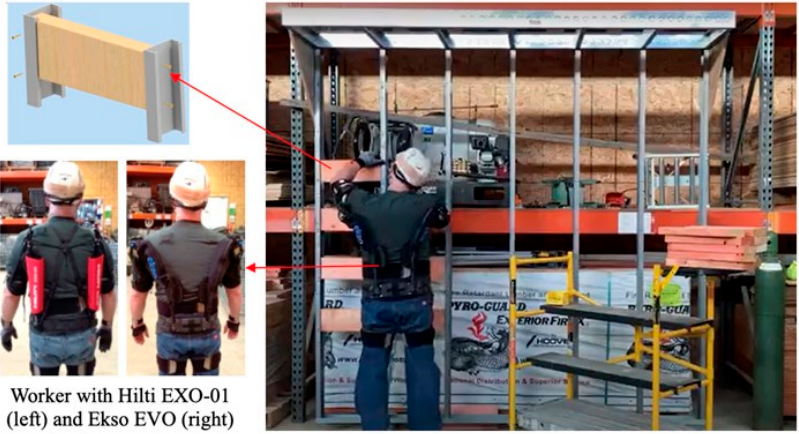
Figure 3. Installing/removing wooden blocks between metal studs.